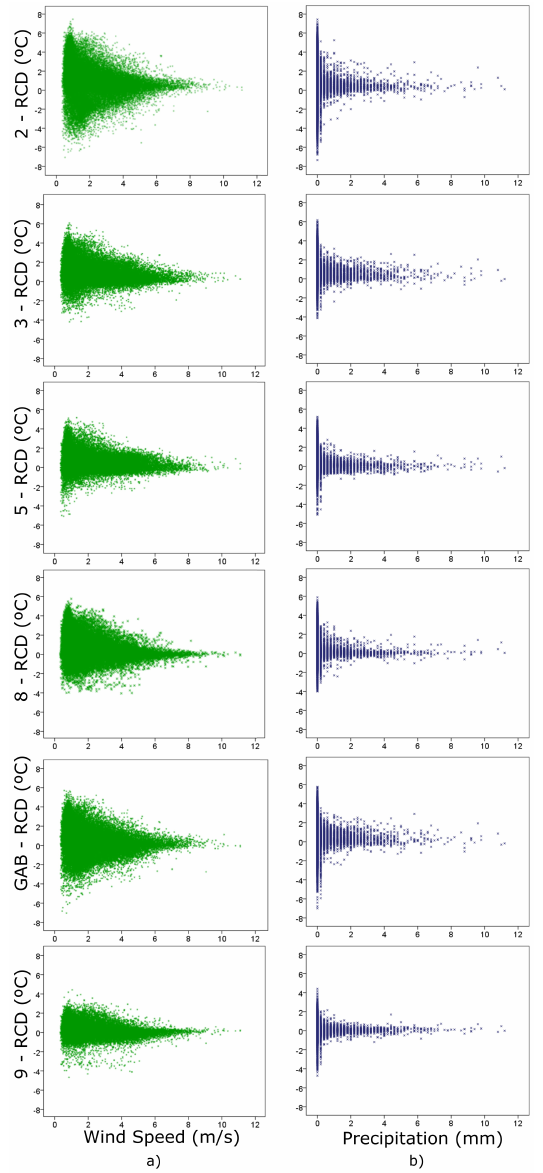
Figure 7. UHI intensity change with the wind speed ( left ) and precipitation ( right